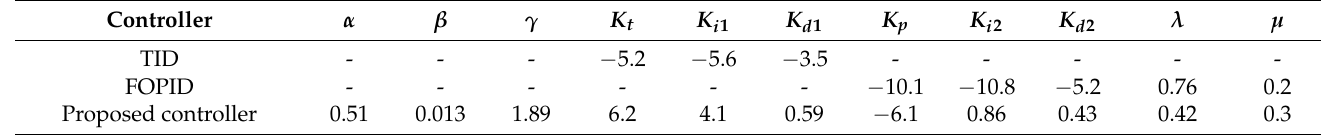
Figure 8. Flowchart of SSA. Table 1. The values of optimal parameters of considered controllers using